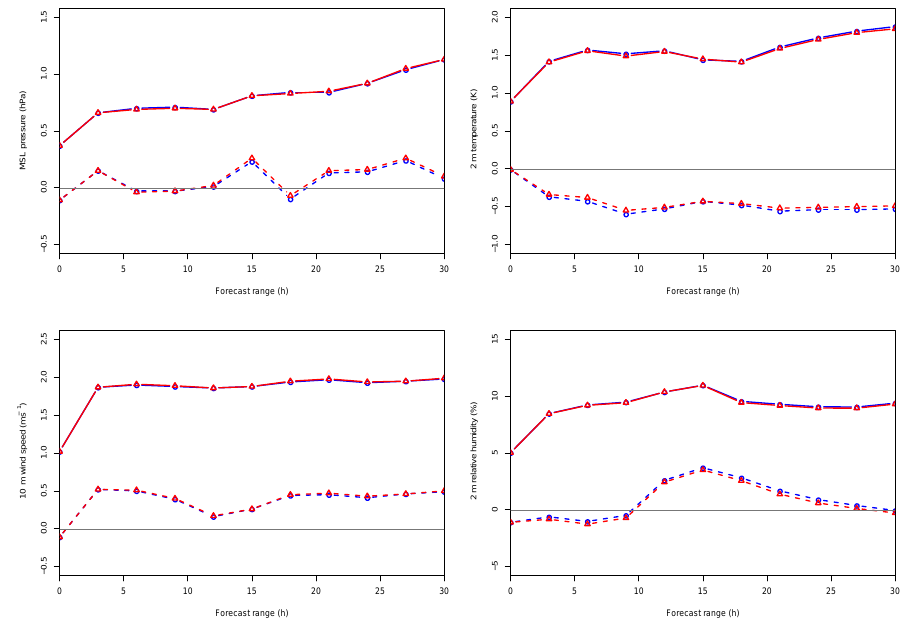
Figure 3. RMSE (solid line) and bias (dashed line) over the period 6 January–6 February 2015, for REF (blue circles) and FCI (red triangles).